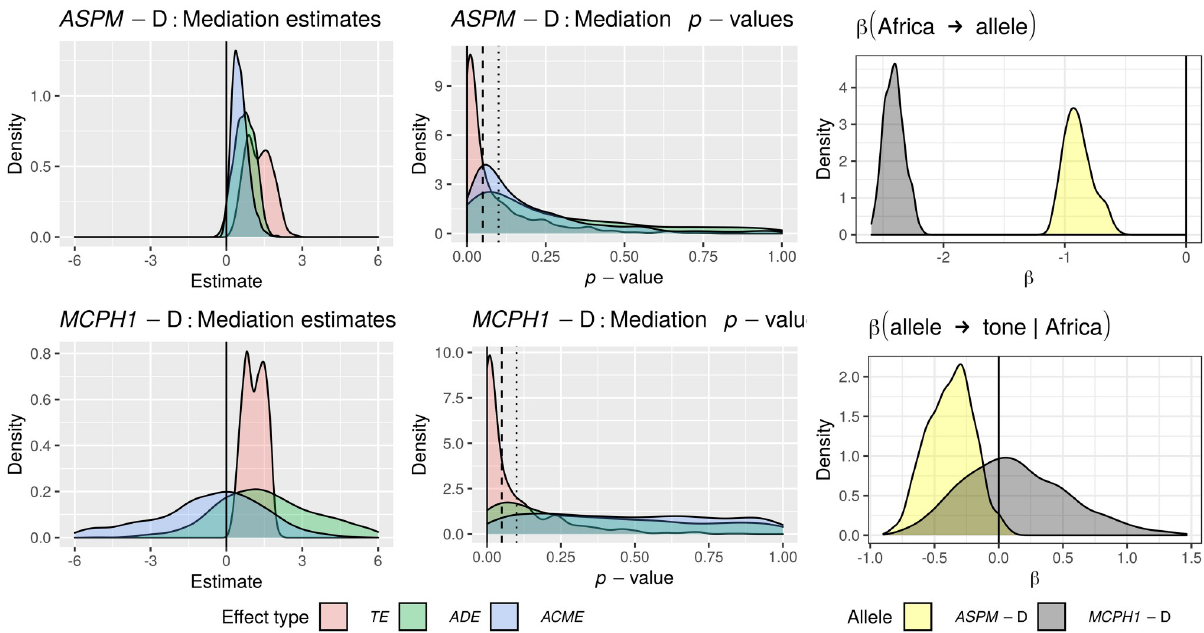
Fig 28. Mediation analysis for 1,000 restricted samples for tone counts . Same conventions as in Fig 11. See Table 11 for the numeric